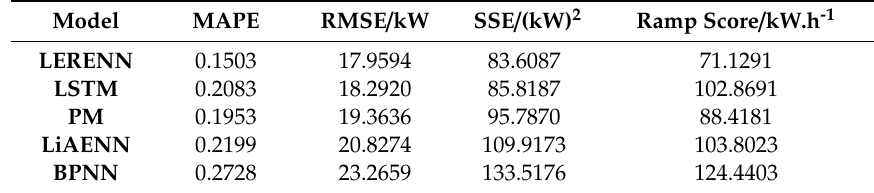
Table 5. Average value of indicators for PV power single-step prediction under di ff erent weather